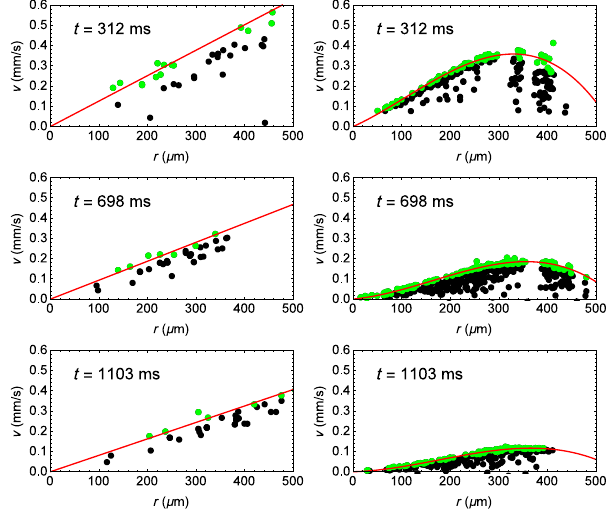
FIG. 15. Dots: Velocity of tracked particles in droplet (left-hand column) and in liquid film (right-hand column). All the graphs are plotted in the same scale. Green dots: Selected fast particles. Red line: Boundary velocity v (left-hand column) and v (right- ra rb hand column) obtained by fitting the fast particles (green dots).